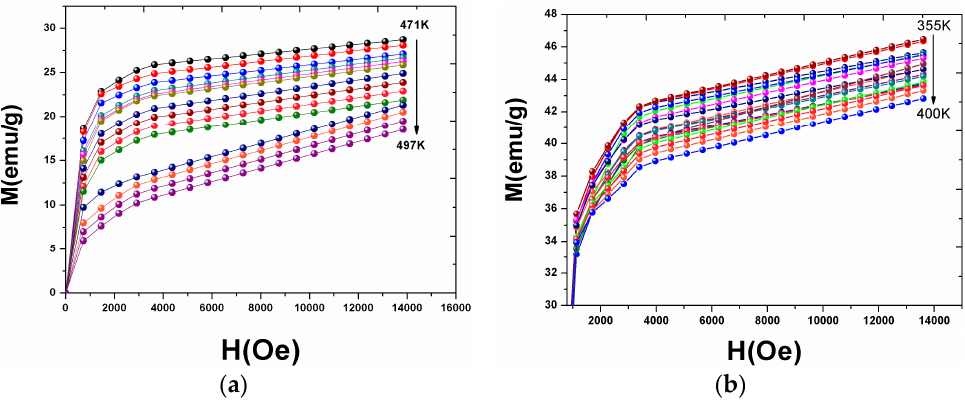
Figure 5. Magnetization versus applied magnetic field isotherms measured for Er 6 Fe 20 Al 3 ( a ) and Er 6 Fe 23 ( b ) compounds.